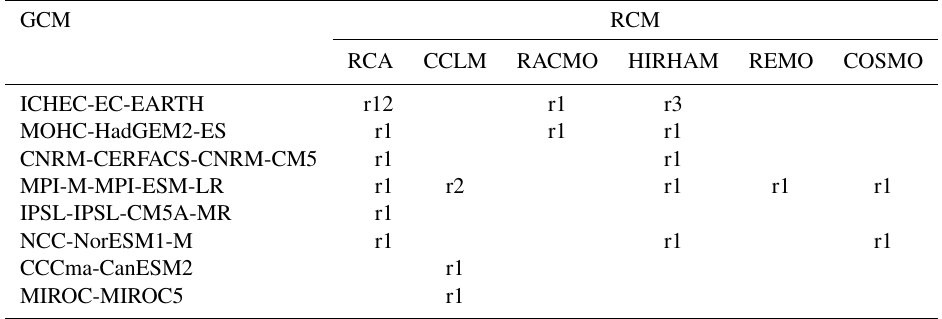
Table 1. Overview of the 19 EURO-CORDEX GCM–RCM combinations used. The rows show the GCMs while the columns show the RCMs. The full names of the RCMs are SMHI-RCA4, CLMcom-CCLM4-8-17, KNMI-RACMO22E, DMI-HIRHAM5, MPI-CSC-REMO2009 and CLMcom-ETH-COSMO-crCLIM-v1-1. Each GCM–RCM combination used is represented by a number (1, 3 or 12) indicating which realisation of the GCM is used for the particular simulation. GCM RCM RCA CCLM RACMO HIRHAM REMO COSMO